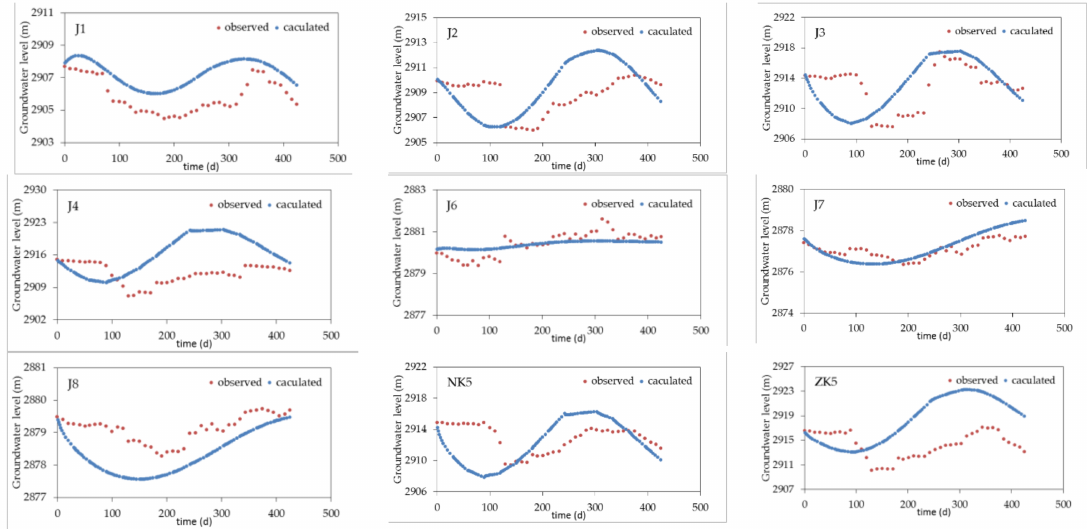
Figure 16. Curves fitted to the groundwater observation wells in the verification